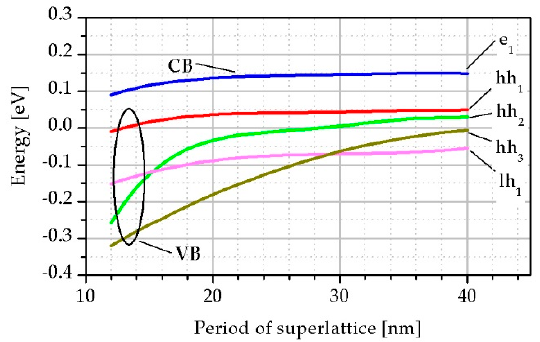
Figure 5. The CB e 1 and VB: hh 1 , hh 2 , hh 3 , lh 1 positions versus SL period.